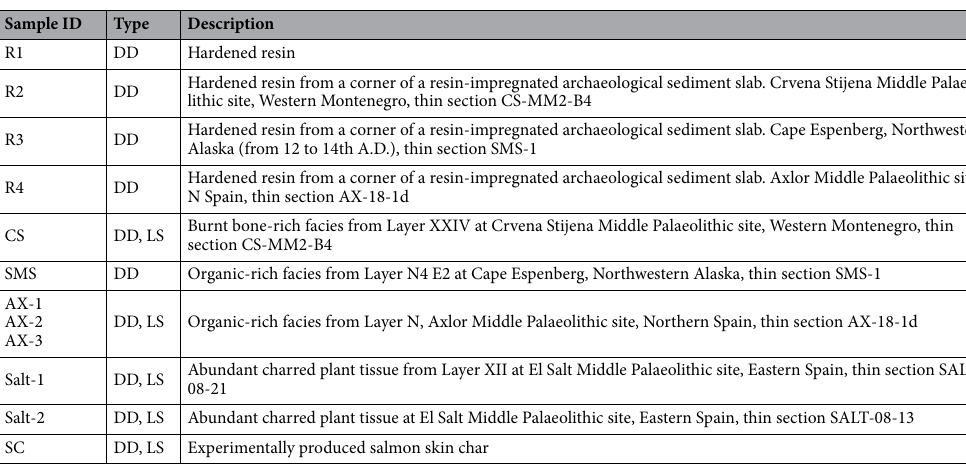
Table 6. List of samples analyzed in this study. DD drill dust from hardened resin or resin-impregnated block, LS loose sediment collected from the same facies, adjacent to the micromorphology